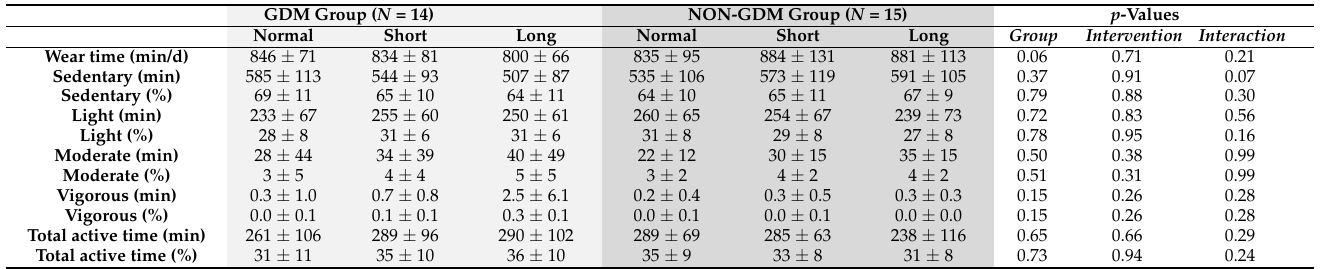
Table 5. Physical activity outcomes during prescribed walking time in women with and without GDM throughout the SHORT and LONG